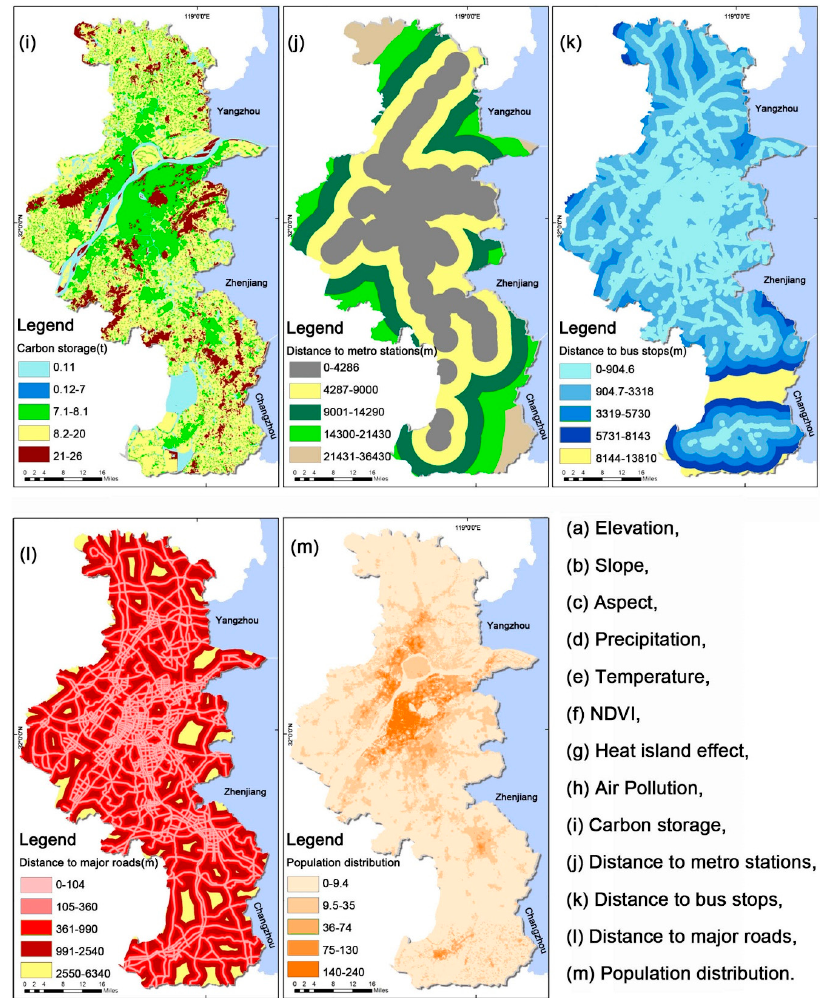
Figure 3. Factors relevant for determining the location of urban parks in Nanjing, China. The normalized difference vegetation index (NDVI) is not affected by cloudiness, at- mosphere, or other factors. The larger the value of this index, the more robust the photo- synthesis and transpiration of the plants, and the more suitable for residents to rest [92]. The heat-island effect (Figure 3g) reflects the urban surface temperature distribution. Ar- eas with a high heat-island effect have higher surface temperatures, therefore, the eco- nomic costs required to site a park on such an area are higher and the ecological benefits harvested are lower [93]. PM2.5 data are an essential indicator of air pollution within a particular area. The higher the PM2.5, the heavier the air pollution in the land area, which is not conducive to park site selection and construction. The carbon storage (developed by